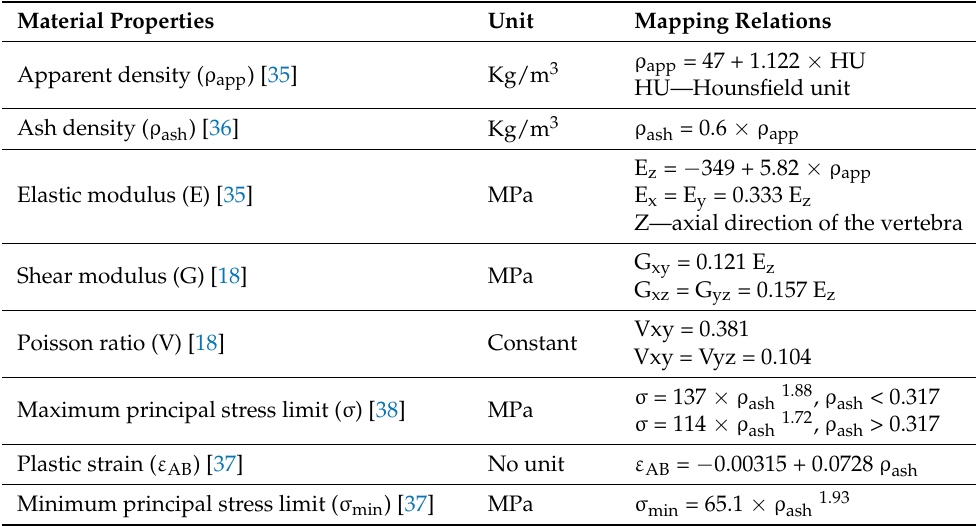
Table 2. Density ( ρ )—intensity (HU)—modulus (E) material mapping relations used in the current computational study for modelling the non-homogenous material behavior.